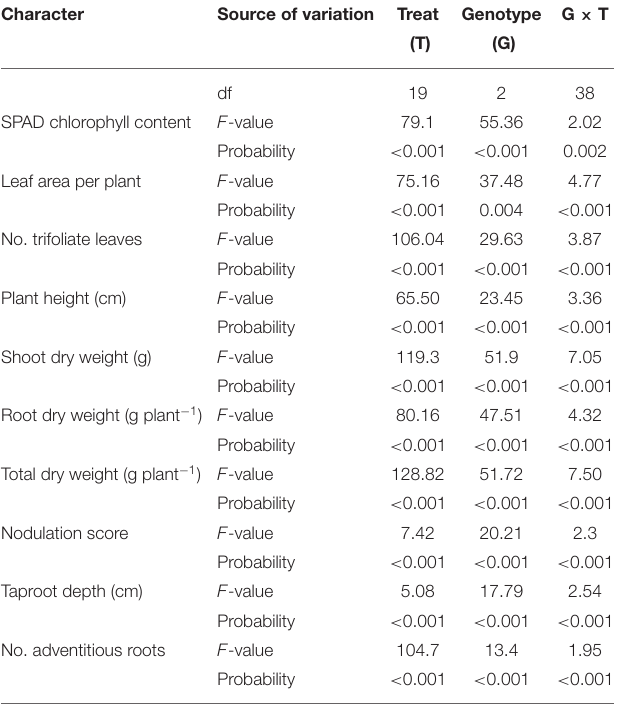
TABLE 3 | Degrees of freedom (df), F -values, and probabilities of two-way ANOVA at the seedling stage. Character